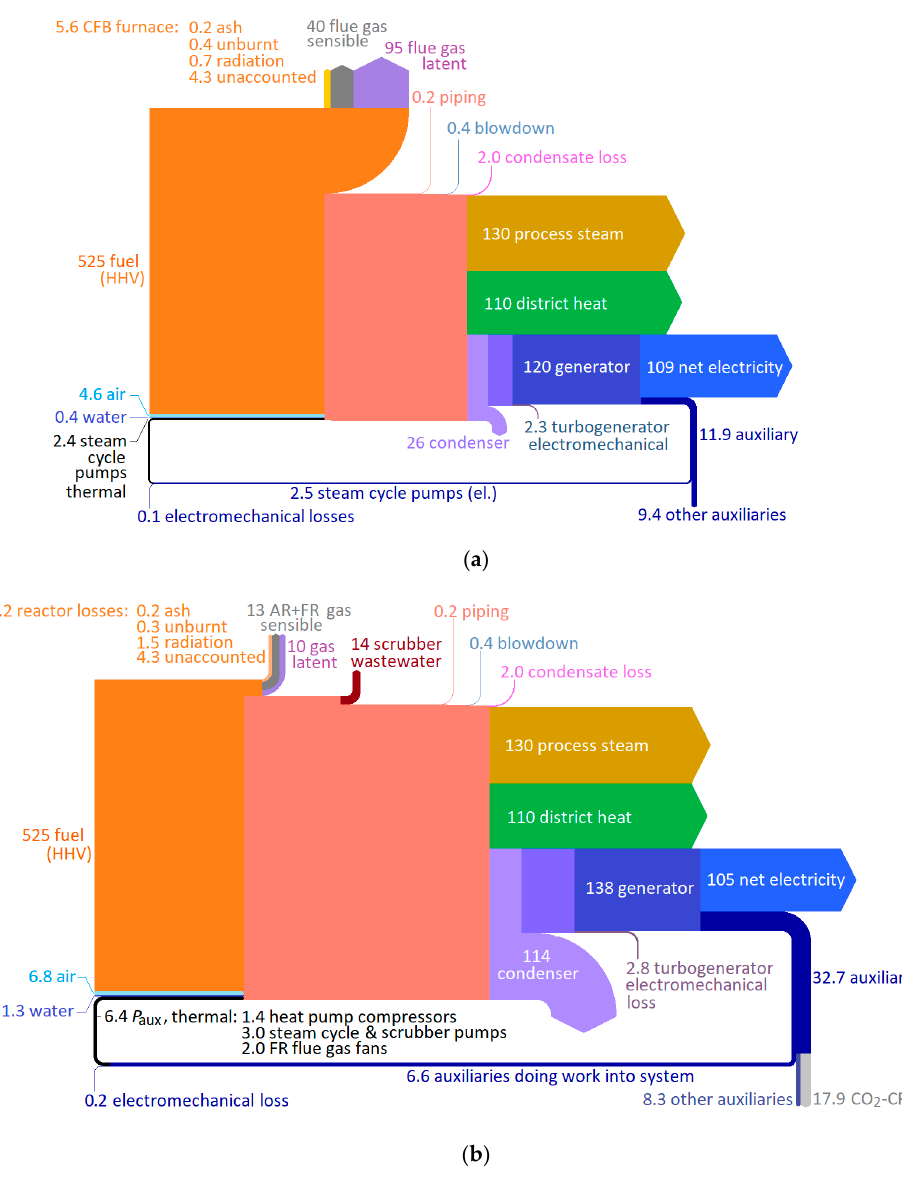
Figure 5. Sankey diagrams showing energy flows in: ( a ) reference plant; and ( b ) CLOU plant. Numbers represent energy flows (MW). The control volume is set at the entry of combustion air into air heaters; work by the forced draft fans is thus considered as a loss, while the enthalpy increase of the air in the fan or blower is considered in the energy entering the system.